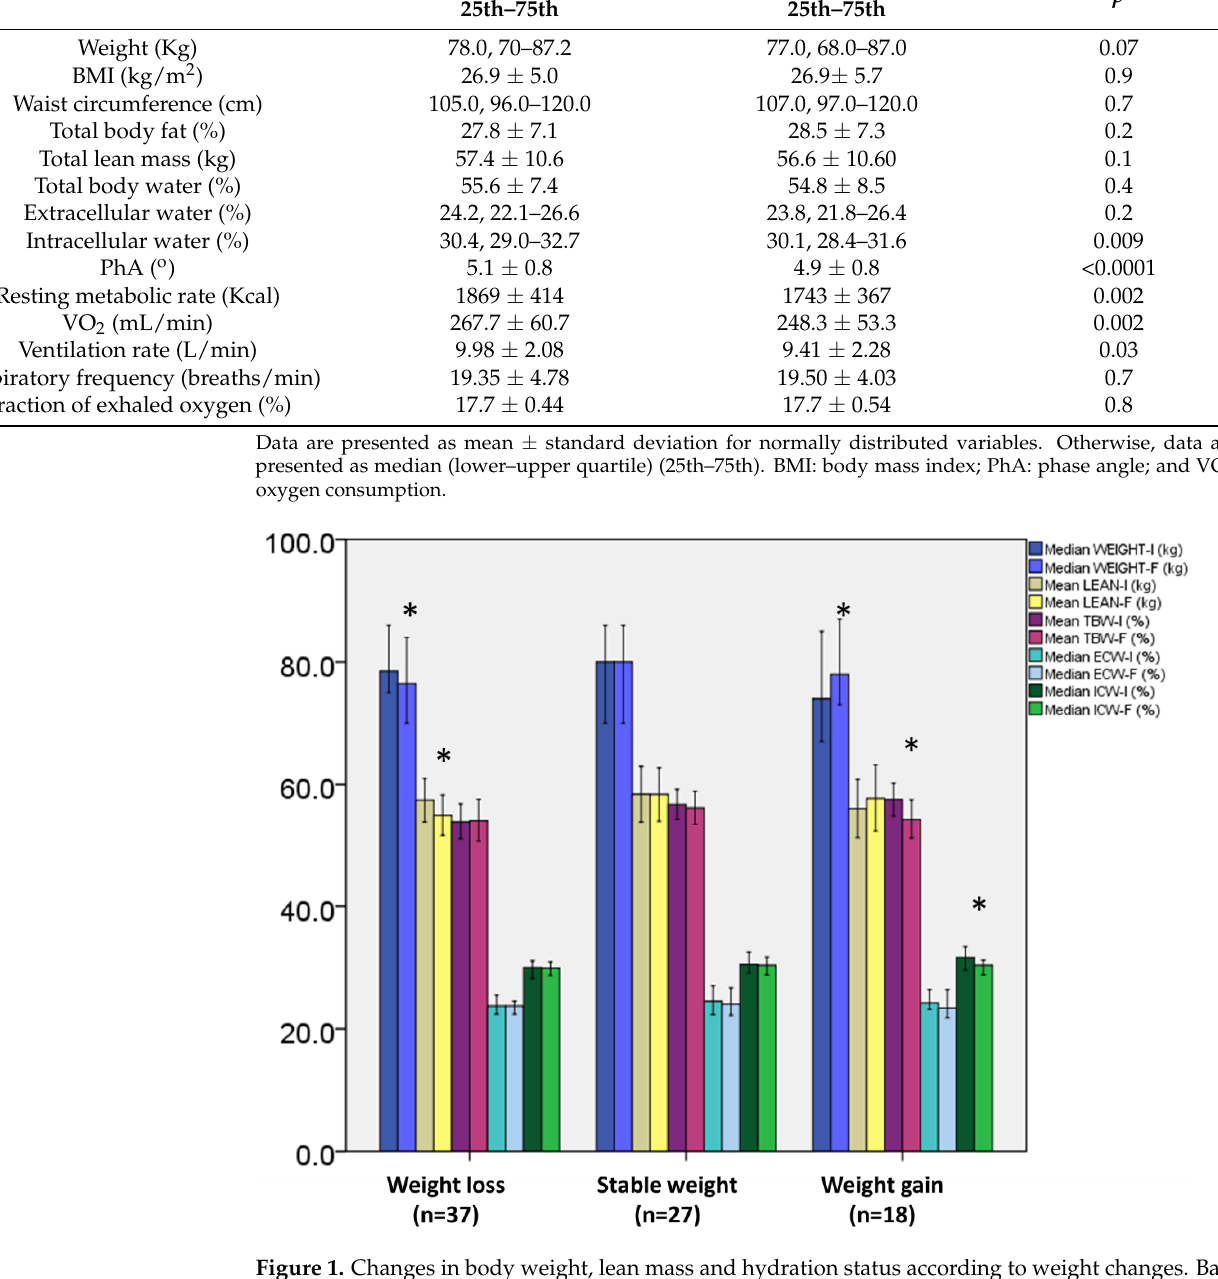
Figure 1. Changes in body weight, lean mass and hydration status according to weight changes. Bars represent mean or median values and 95% confidence intervals. * denotes p -value< 0.05. I: initial; F: final; TBW: total body water; ECW: extracellular water; and ICW: intracellular water. Table 3. Changes in body composition and resting metabolic rate according to weight changes.